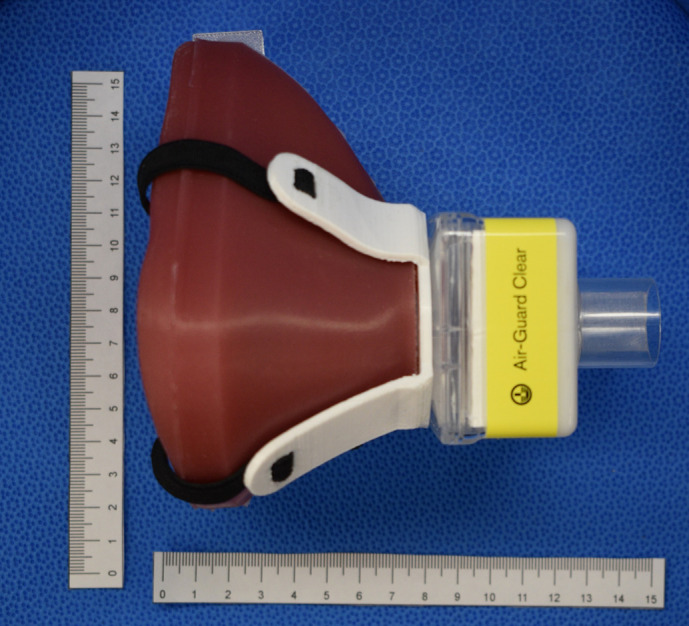
Assembled SSM respirator mask.